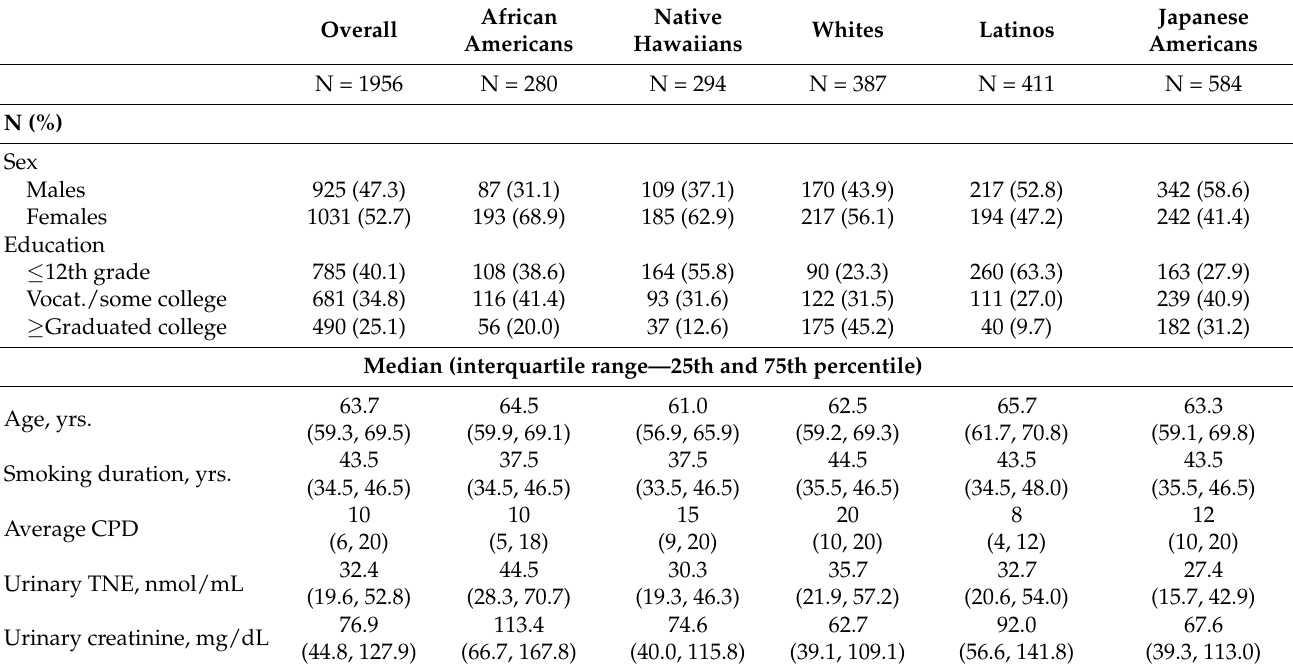
CPD—self-reported cigarettes per day; TNE—total nicotine